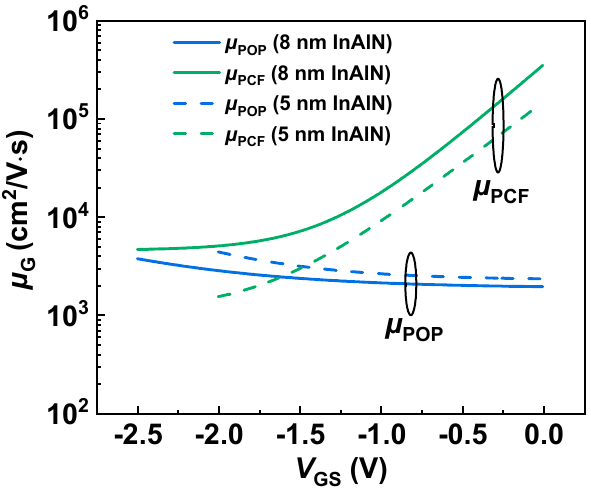
Figure 7. Comparison of µ POP and µ PCF versus V GS of both samples.